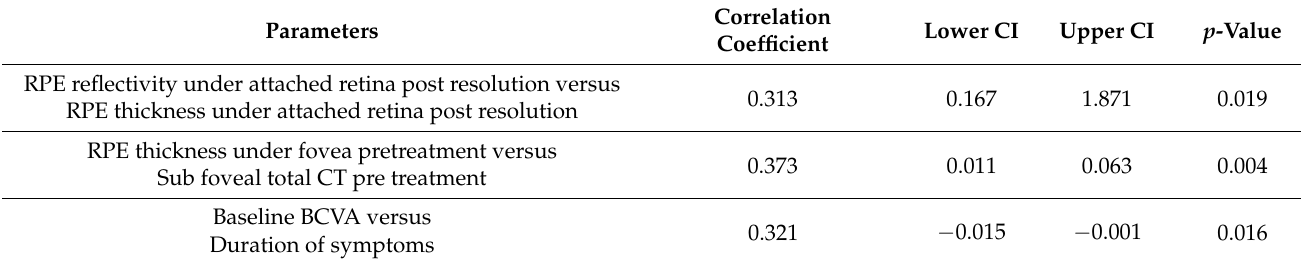
Table 2. Correlation between different parameters.